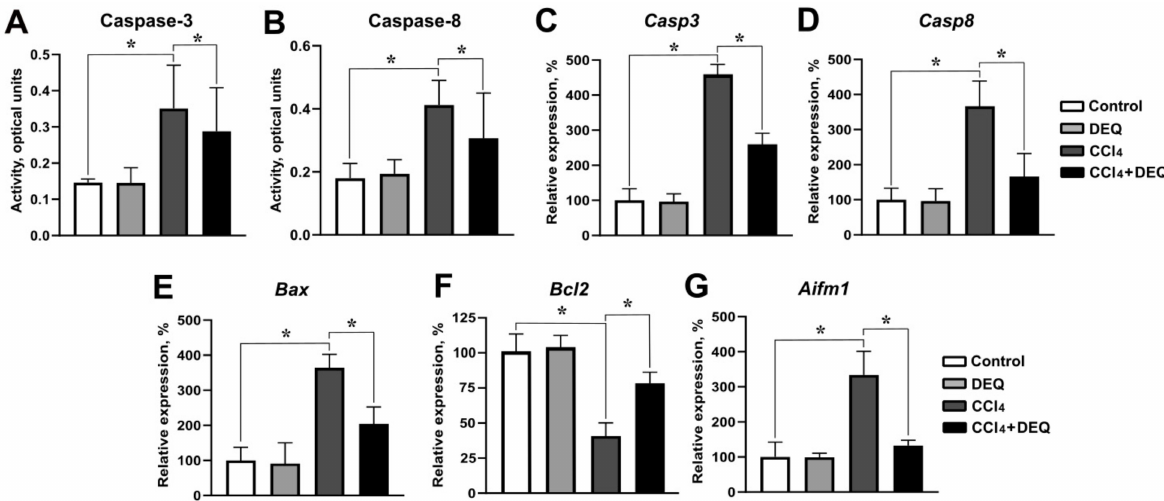
Figure 5. Effect of DEQ administration on hepatic apoptosis in rats with CCl 4 -induced liver injury. The caspase-3 ( A ) and caspase-8 ( B ) activities were significantly increased in the liver of animals from CCl 4 group compared to the control group. CCl 4 administration resulted in a significant increase in the Casp3 , Casp8 , Bax , and Aifm1 mRNA levels ( C–E , G ), while the expression of Bcl2 was significantly decreased ( F ). Treatment of rats with DEQ 3 h after CCl 4 administration every 24 h for 4 days significantly reduced CCl 4 -induced caspase-3 ( A ) and caspase-8 ( B ) activities in the liver of rats as well as Casp3, Casp8, Bax, and Aifm1 mRNA levels ( C – E , G ). Treatment with DEQ significantly increased CCl4-reduced expression of Bcl2 ( F ). * p < 0.05. Activity values expressed as optical units per milligram of protein. All data are expressed as mean ±